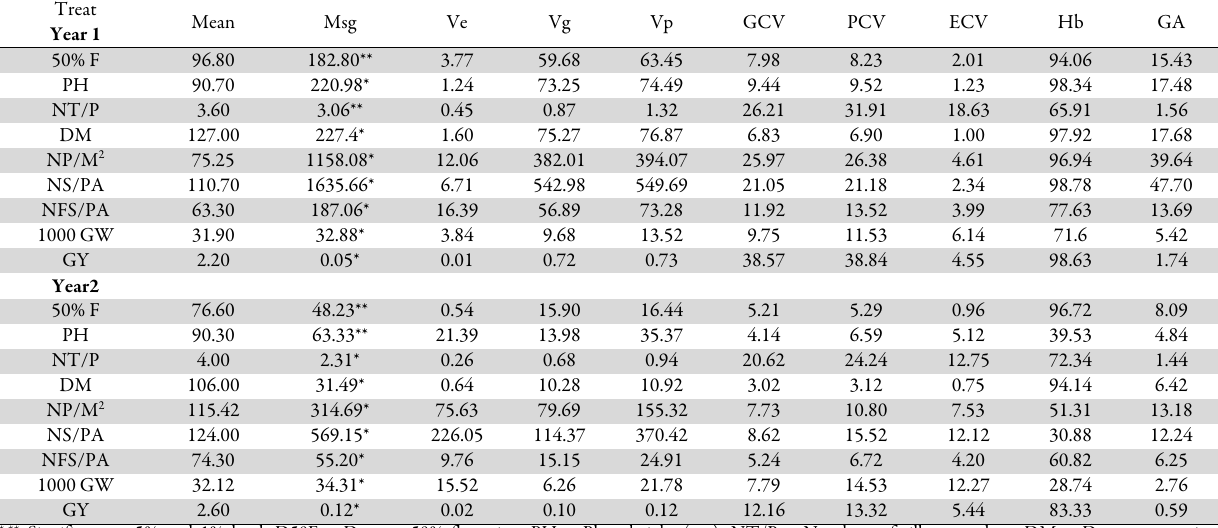
Table 5. Variance, broad sense heritability and genetic advance estimates for nine agronomic characters for the twelve (12) rice genotypes across the two years of the